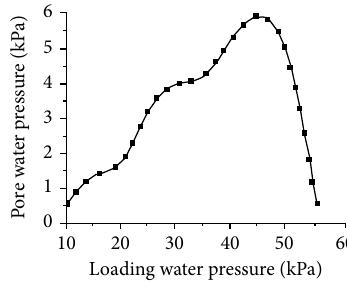
Figure 11: Characteristics of pore water pressure changes at monitoring points during hydraulic loading